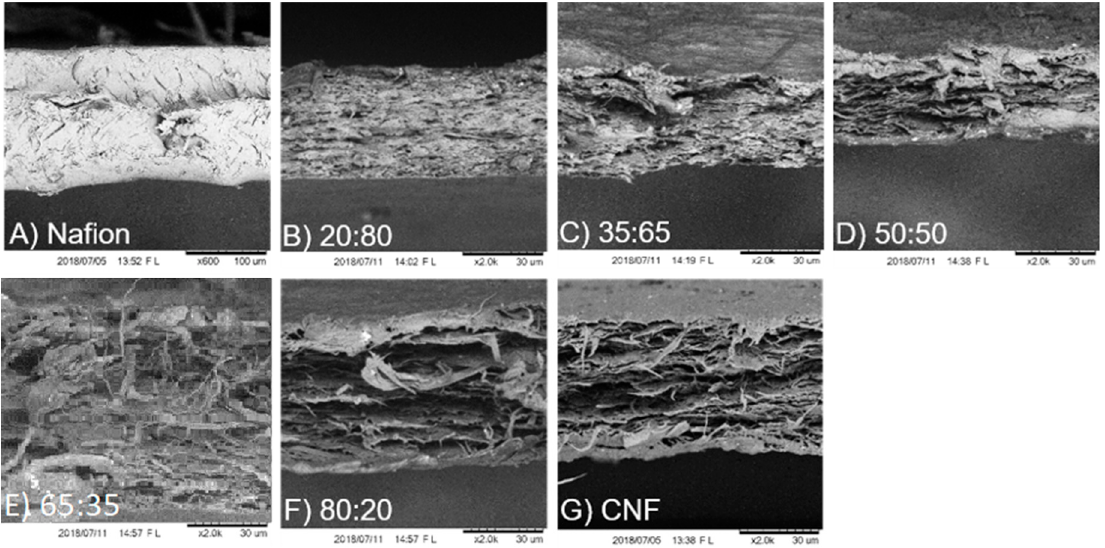
Figure 2. SEM cross-sectional images of Nafion® at 600× magnification ( A ), Pure CNF ( G ), and different ratios of CNF to Nafion® membranes after rupture in tensile analysis: 20:80 ( B ), 35:65 ( C ), 50:50 ( D ), 65:35 ( E ), 80:20 ( F ) at 2K magnification. The average thickness was 50 µm.